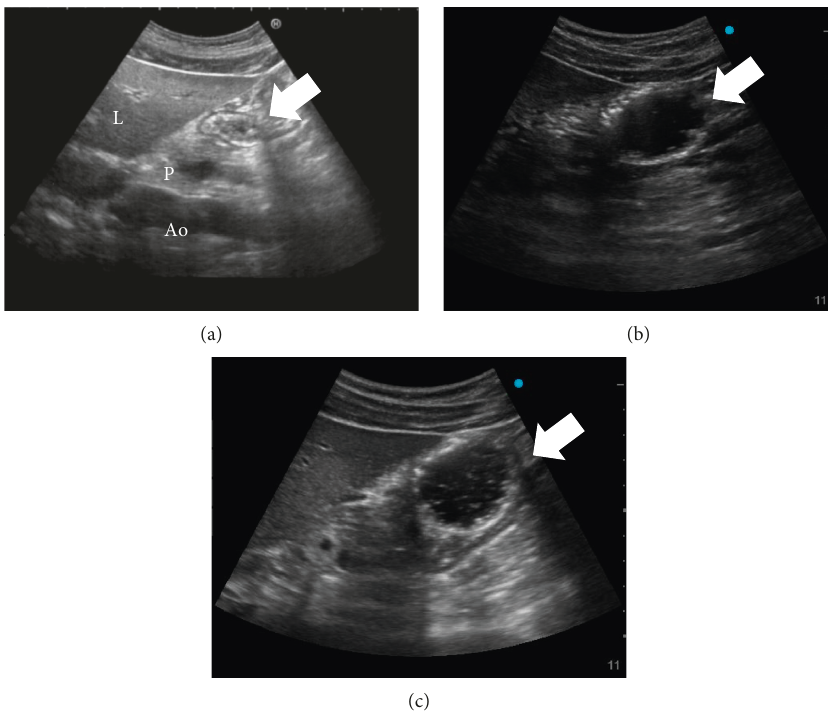
Figure 1: (a) Sagittal sonogram of the empty gastric antrum. The antrum is located between the left lobe of the liver and the pancreas at the level of the aorta or inferior vena cava. (b) Sagittal sonogram of the gastric antrum 10 minutes after the ingestion of 150ml of diluted whisky (30ml of whisky +120ml of water). The antrum appeared distended with a hypoechoic fluid content. (c) Sagittal sonogram of the gastric antrum 10 minutes after the ingestion of 150ml of 12.5% glucose solution. The antrum appeared distended with hypoechoic fluid. Arrow, antrum; L, liver; P, pancreas; Ao,